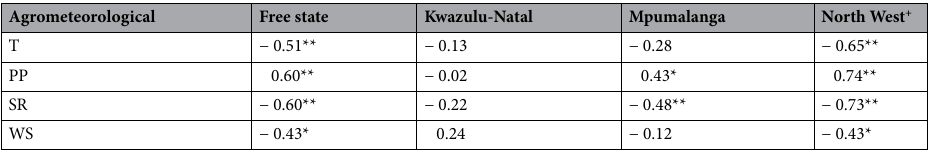
Table 3. Pearson correlation coefficient (r) between growing season data of agrometeorological variables and maize yield (see Table 1 for abbreviations). **Significant level at α < 0.01; *significant level at 0.01 < α ≤ 0.05; + yield data was transformed using boxcox.